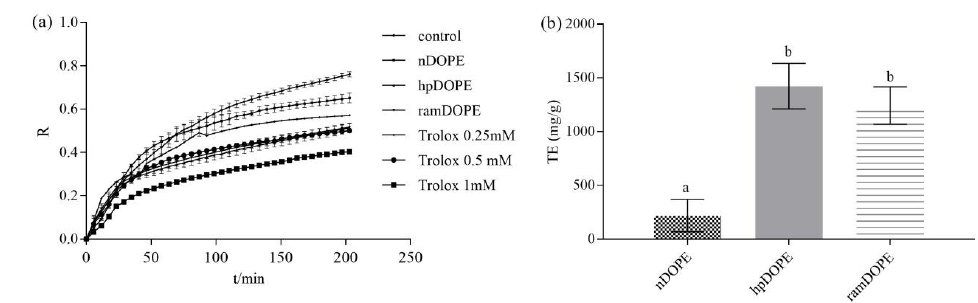
Figure 3. Antioxidant activity of DOPE in the β -carotene emulsion model system. ( a ): β -carotene absorbance inhibition ratio during 120 min incubation; ( b ): antioxidant activity expressed as IC